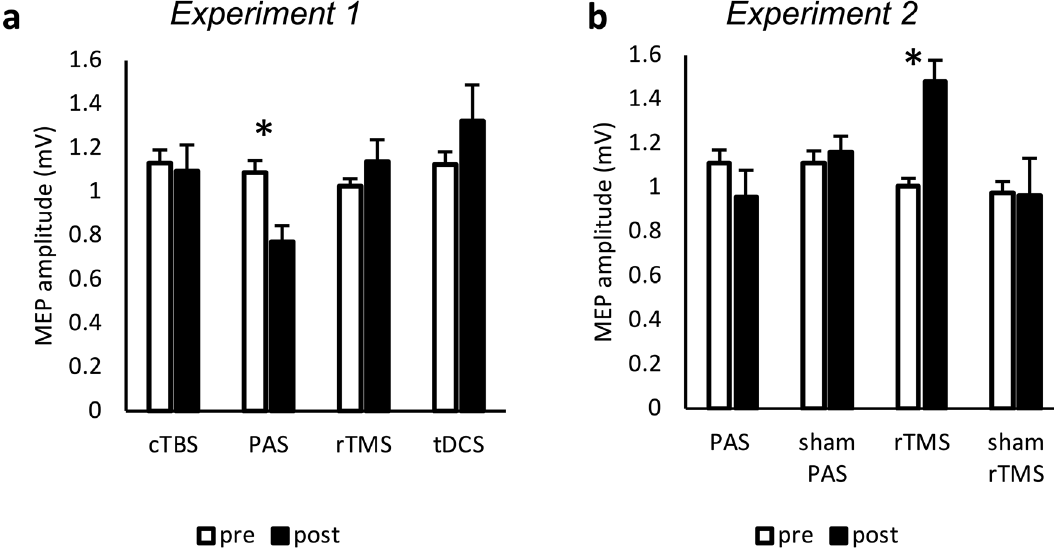
Figure 3. Analysis of MEPs (experiments 1 and 2). MEPs were measured peak-to-peak and are indicated in mV. Error bars indicate standard error of mean. Graphs are marked with * when comparison of values with student-t-test resulted in p value < 0.05 (Bonferroni–Holm-corrected). ( a ) Significant decrease of MEP amplitude after PAS intervention ( p = 0.044). ( b ) Significant increase of MEP amplitude after rTMS intervention ( p = 0.004). MEP motor evoked potential, PAS paired associated stimulation, rTMS repetitive transcranial magnetic stimulation, cTBS continuous theta-burst, tDCS transcranial direct current